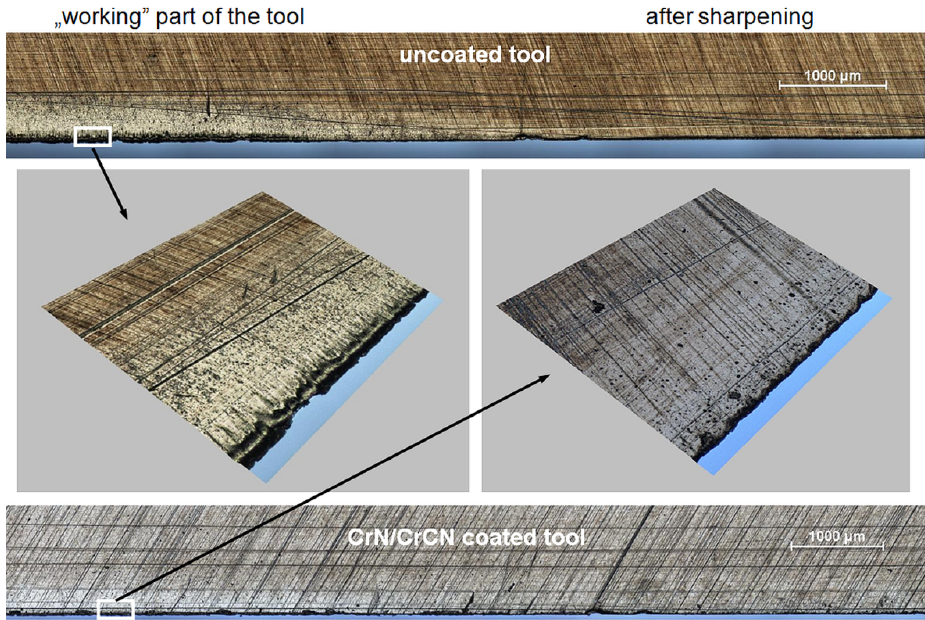
Figure 2. Fragments of uncoated HS6-5-2 steel knives ( top ) and CrN/CrCN ( bottom ). The left part after processing pine wood; the right part, after sharpening, did not process the wood [82].